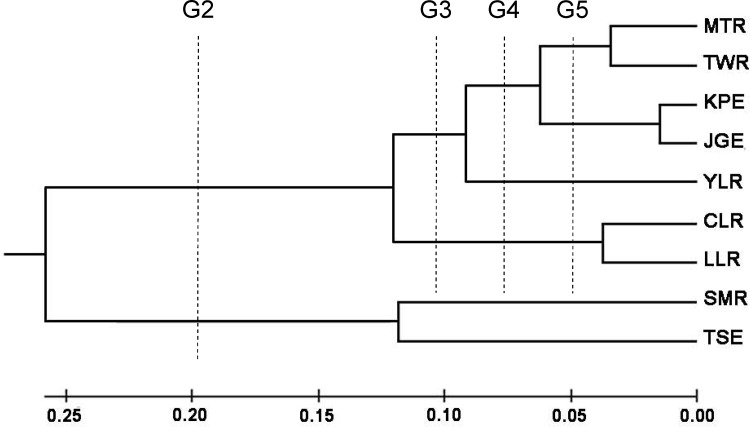
UPGMA tree showing relationships among the 9 sampling sites.